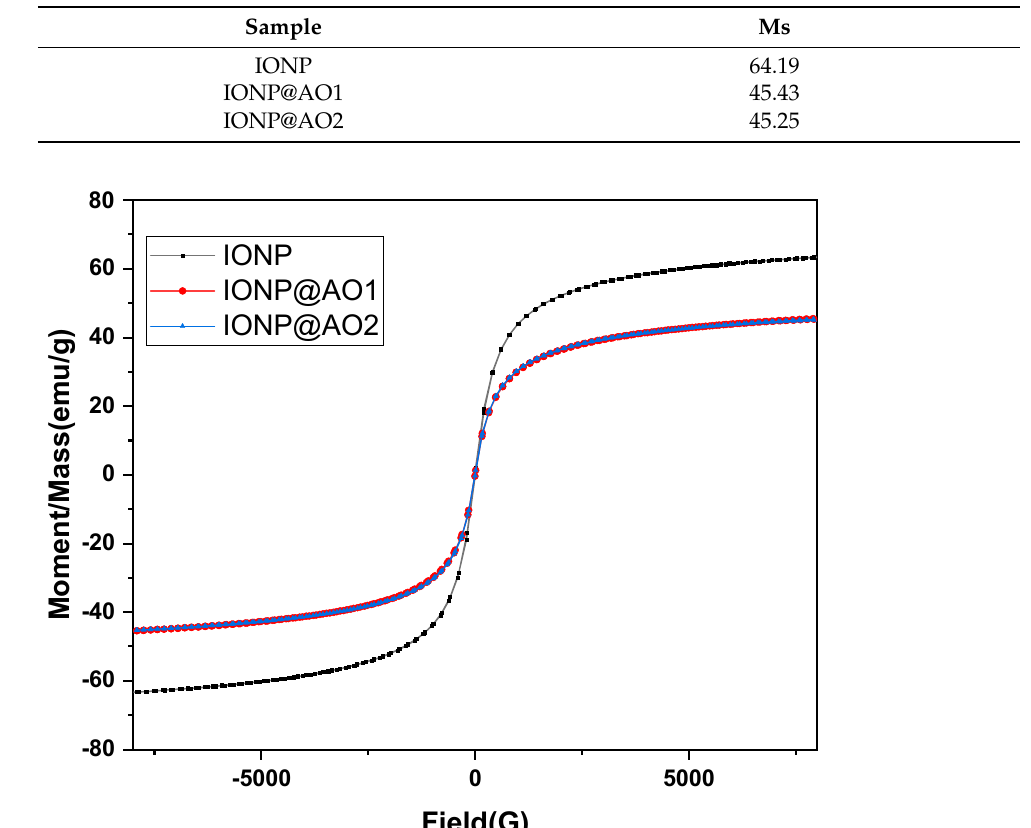
Table 1. Magnetic properties of unfunctionalized IONP and functionalized IONP@AO.